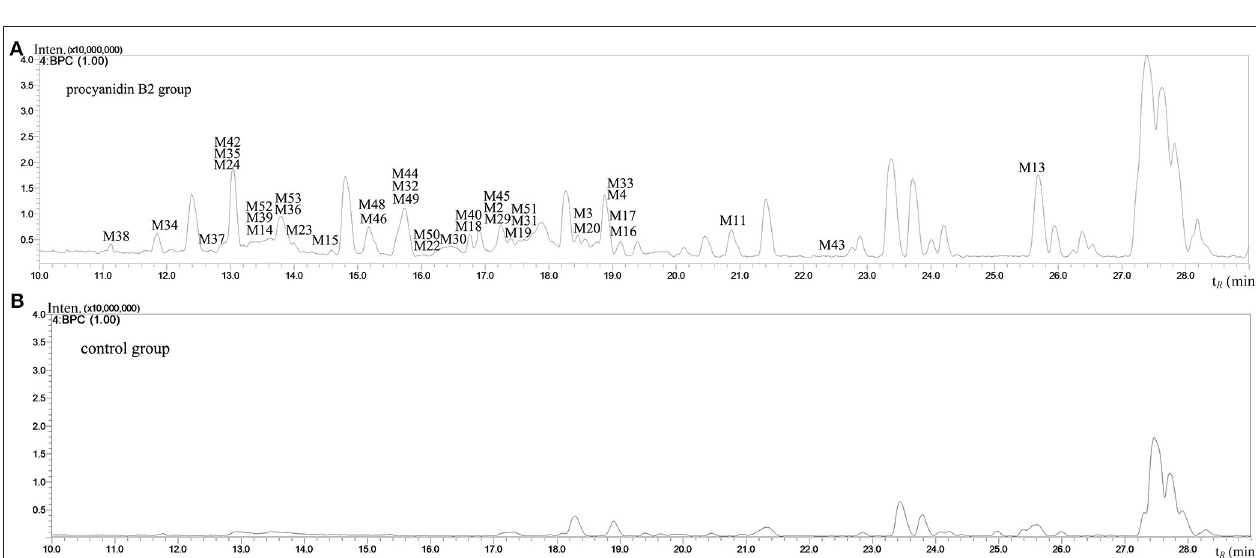
Frontiers in Pharmacology | www.frontiersin.org